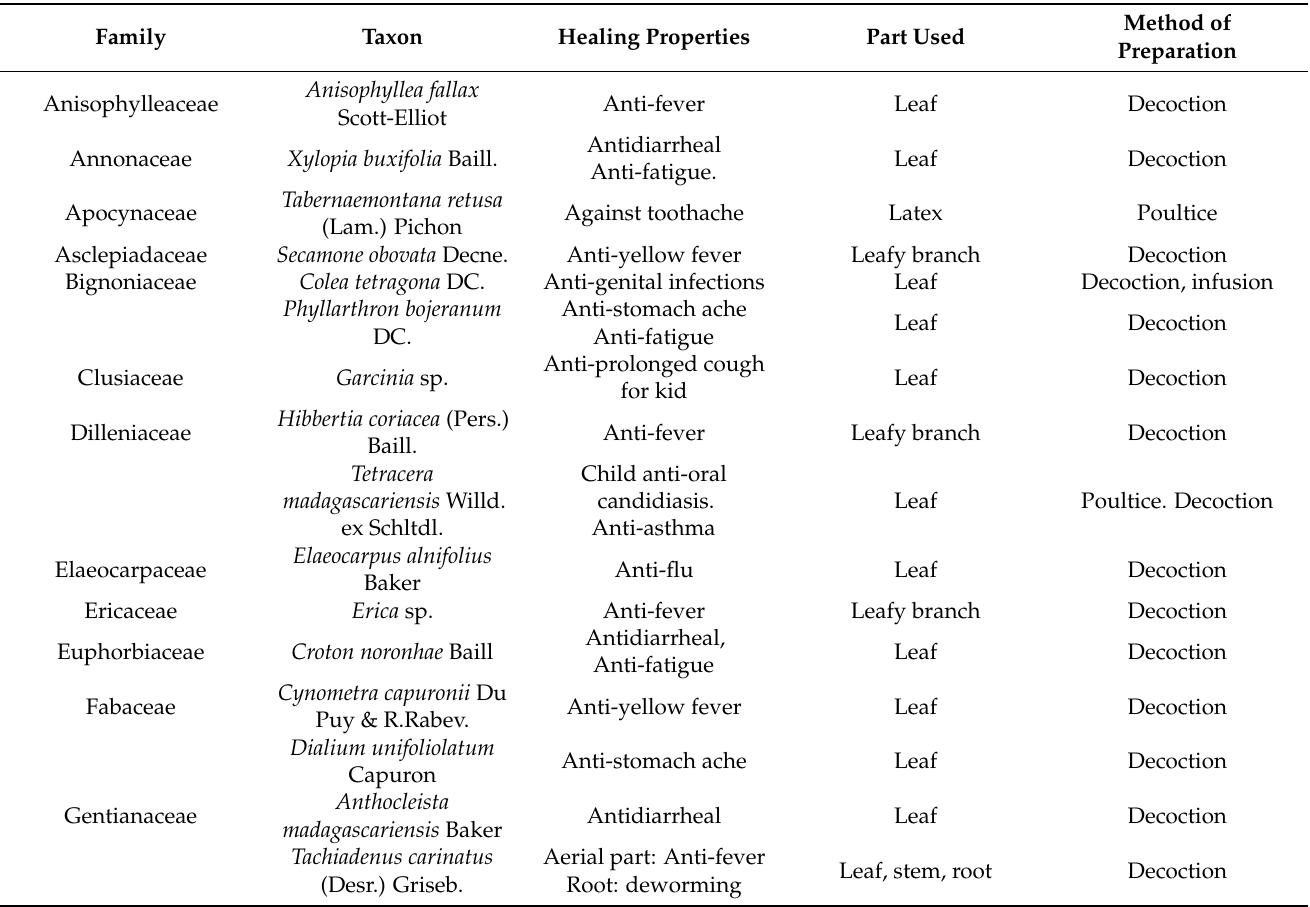
Figure 3. Distribution of taxa for each lifeform. Table 3. Method of use of the forest medicinal